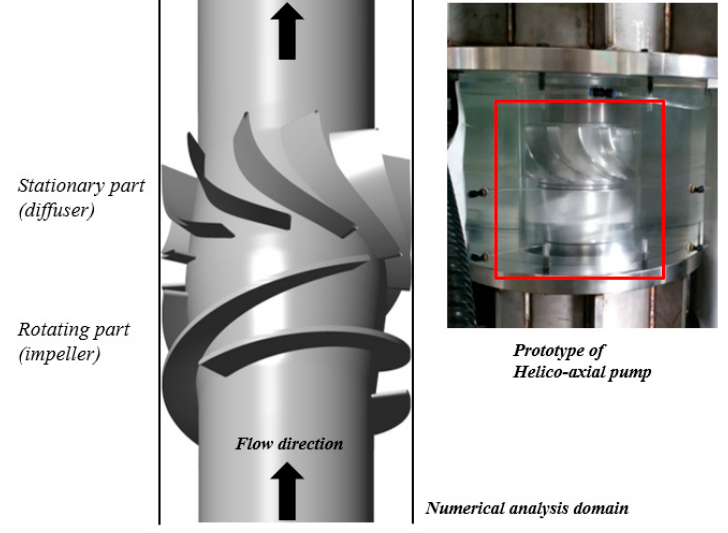
Figure 1. Helico-axial multiphase pump.